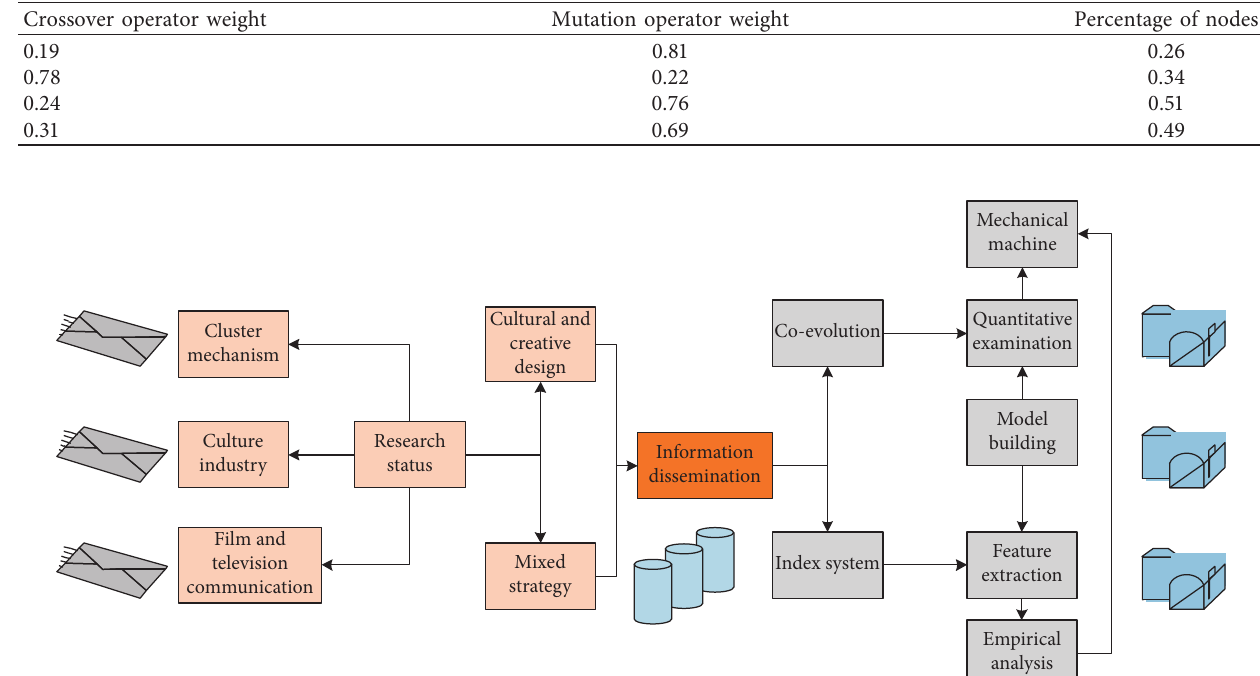
Table 3: List of model weight parameters.